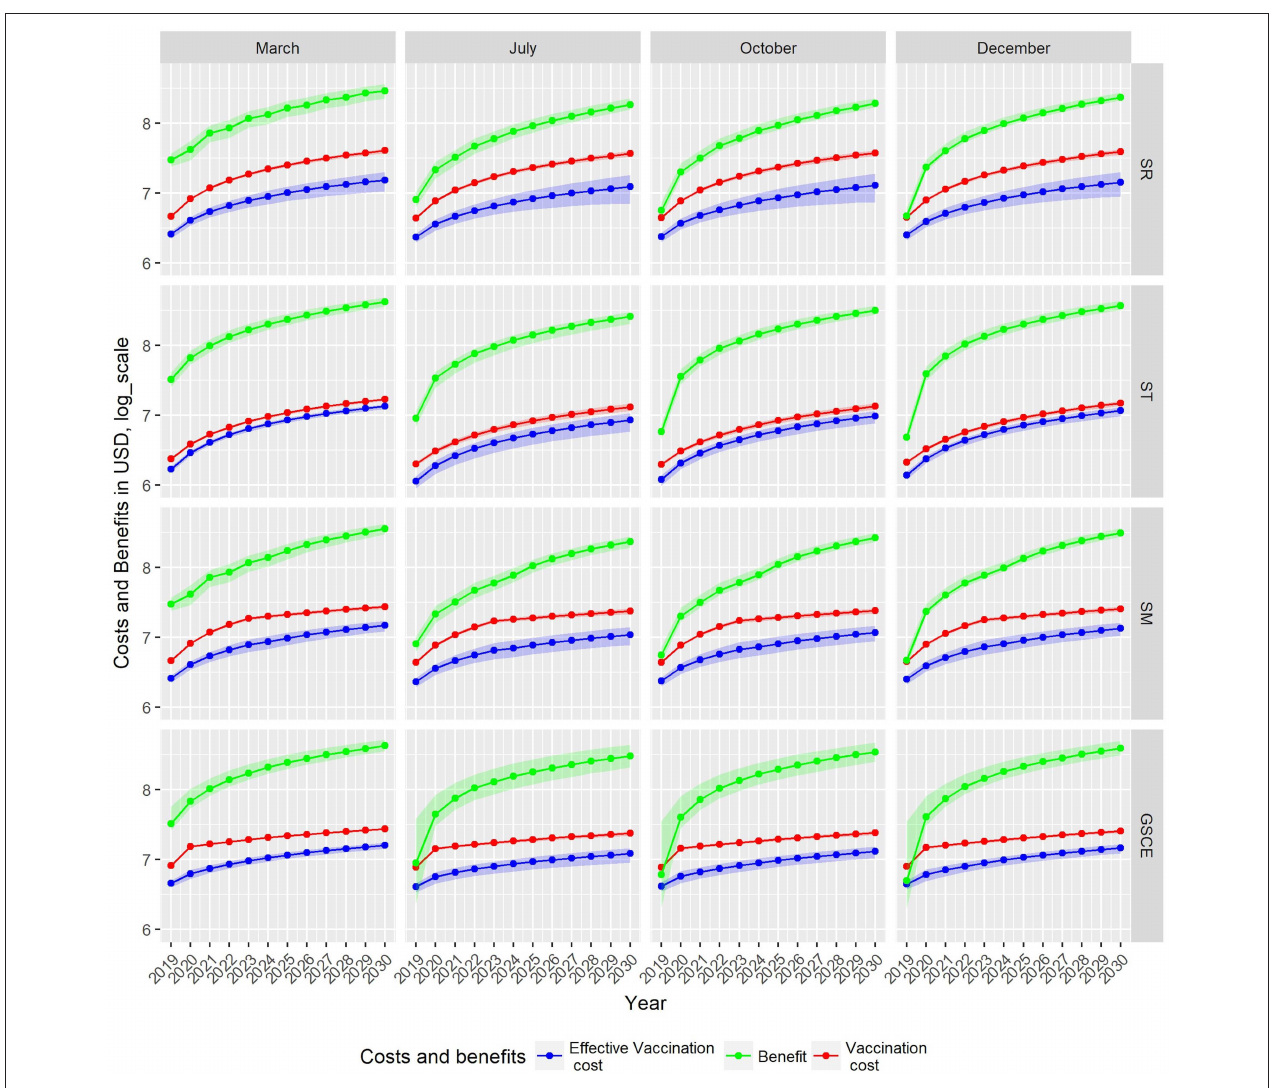
FIGURE 8 | Cumulative cost and benefit for each strategy (row) and month of vaccination. Green indicates benefits from averted mortality, red the vaccination cost, and blue the loss due to wasted vaccination, all expressed in U.S. Dollars. Due to different scales of costs and benefit, estimates are given in Log 10